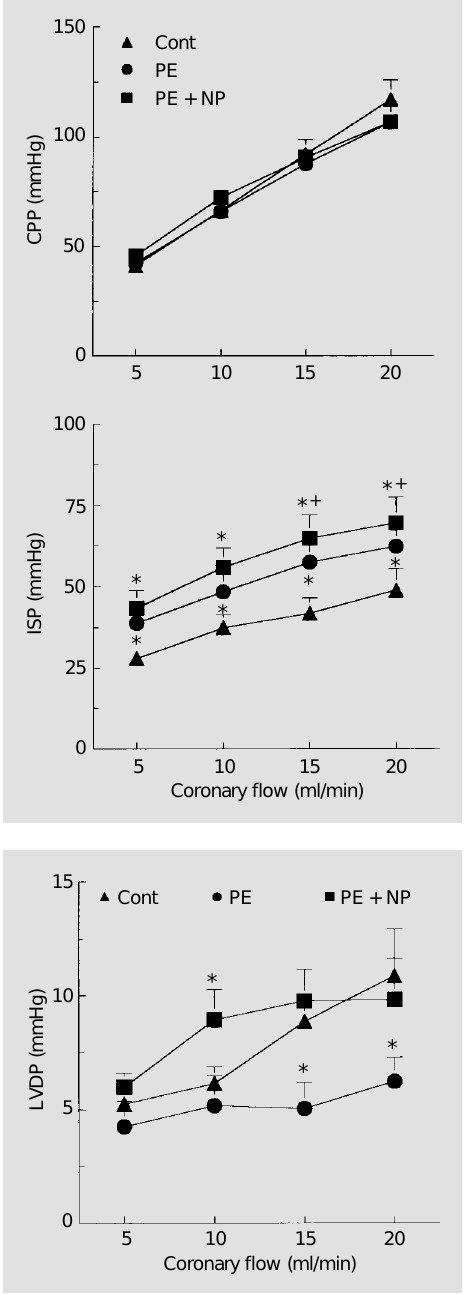
Figure 2 - Upper panel , Effects of increases of coronary flow on the coronary perfusion pressure (CPP) obtained under control conditions (Cont), during phen- ylephrine (PE) perfusion and dur- ing simultaneous perfusion of PE plus nitroprusside (NP). Lower panel , Effects of in- creases of coronary flow on the isovolumic systolic pressure